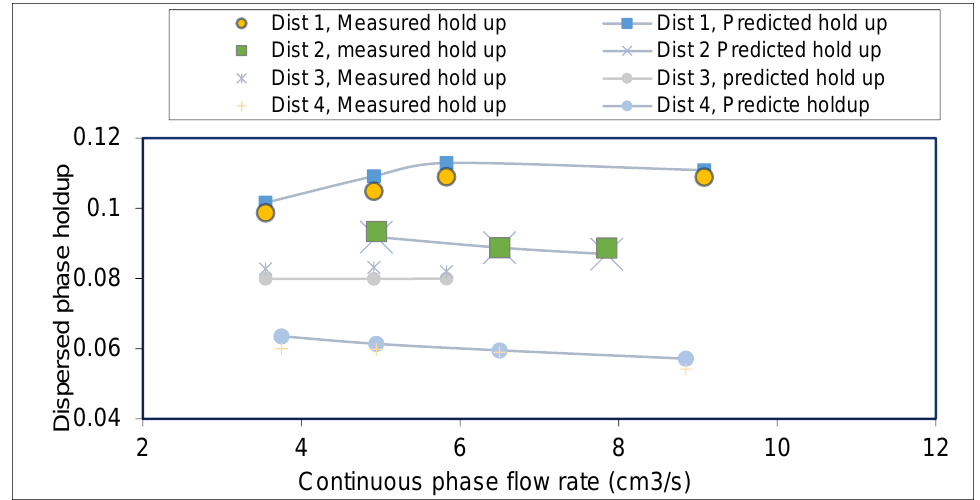
Figure 4. Dispersed phase holdup, effect of continuous phase flowrate at a disc speed of 9.666 rps. Measured holdup (symbols) and predicted holdup (lines).